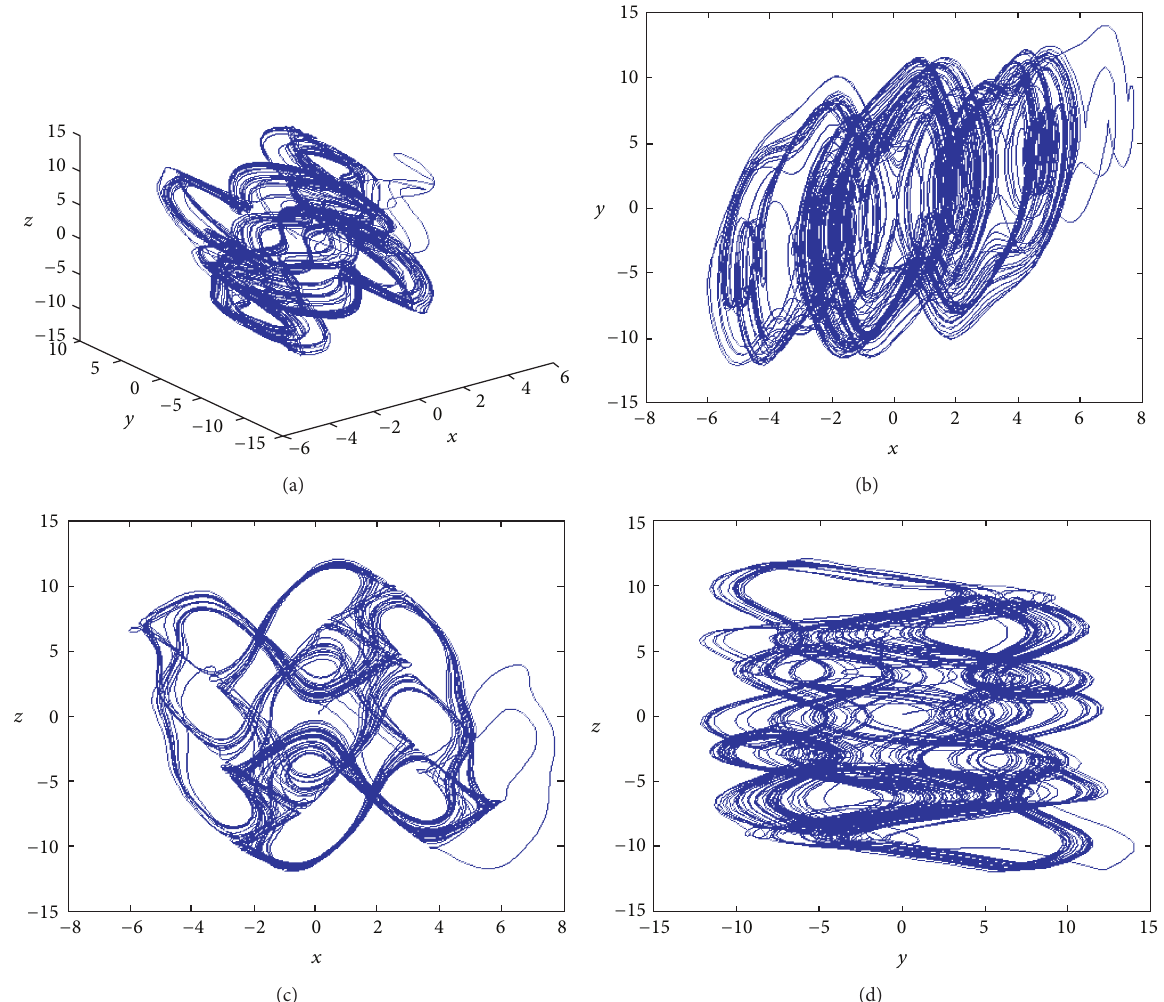
Figure 1: (a) Chaotic attractor given by (1) with 𝑎 = −1 , 𝑏 = 1 , 𝑐 = −1 , 𝑑 = 36 , and 𝑒 = 18 , and projection of the chaotic attractor on the (b) 𝑥 − 𝑦 plane, (c) 𝑦 − 𝑧 plane, and (d) 𝑥 − 𝑧